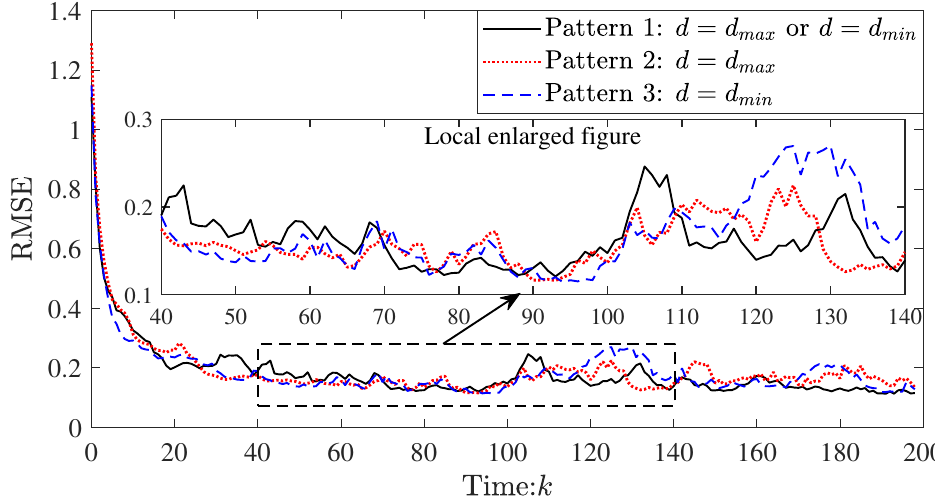
Figure 5. The RMSEs of three